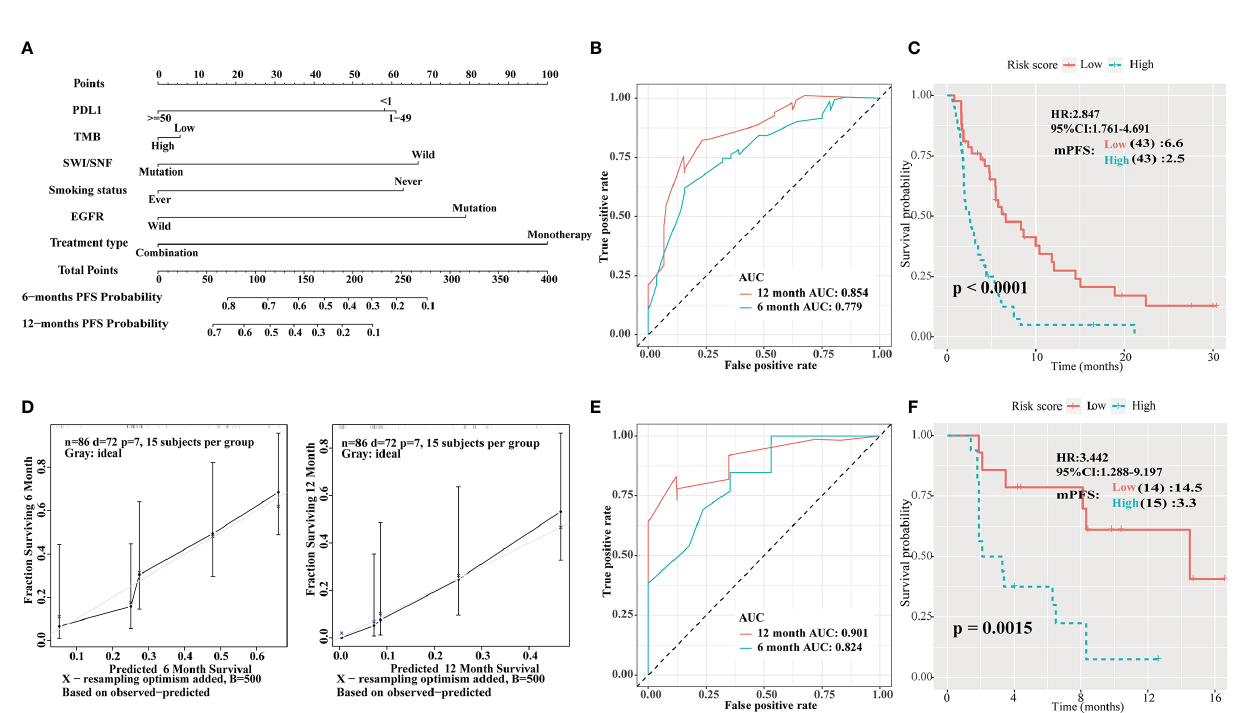
FIGURE 5 | Construction of an integrated prognostic classi fi er model. (A) Nomogram based on programmed death ligand 1 (PD-L1) score, tumor mutation burden (TMB), human switch/sucrose nonfermentable (SWI/SNF) mutation status, smoking history, epidermal growth factor receptor (EGFR) mutation status, and treatment type of the Rizvi cohort. (B) Receiver operating characteristic (ROC) curves for predicting progression-free survival (PFS) of the nomogram in the Rizvi cohort. (C) Calibration plot of the nomogram for the probability of PFS at 6 (left) and 12 (right) months in the Rizvi cohort. (D) Survival curve of PFS with the nomogram in the Rizvi cohort. The risk score was calculated according to the regression coef fi cient. The cohort was divided into low- and high-risk score groups for Kaplan-Meier curve analysis. (E) ROC curves for predicting PFS of the nomogram in the Naiyer cohort. (F) Survival curve of PFS with the nomogram according to the risk score in the Naiyer